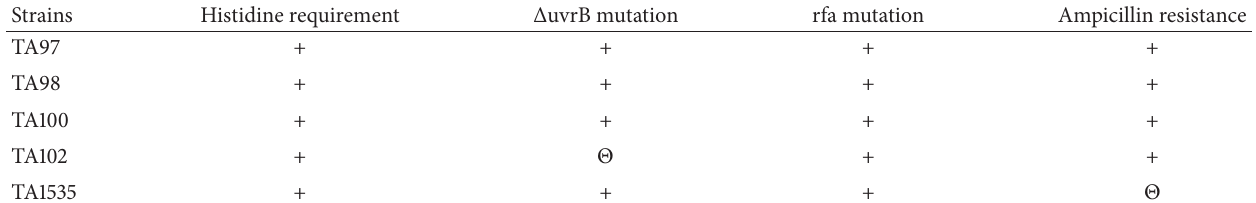
Table 2: Genotyping of the test bacterial